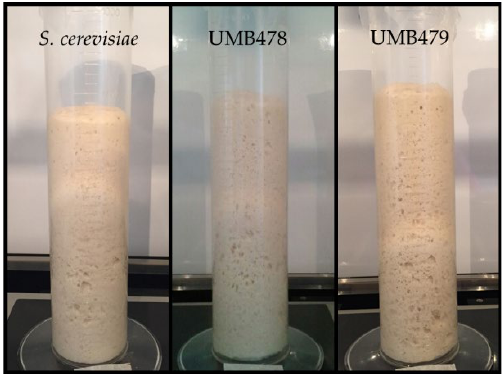
Figure 2. Doughs leavened (6 h) by S. cerevisiae , Z. mobilis UMB478 and UMB479. Z. mobilis UMB478 produced a maximum dough volume increase of 588 ± 18 mL in 6 h of leavening, doubling the initial volume in 3.5 h. The total CO 2 produced was only 34.6 ± 5.4 mL, and the dough pH decreased from 5.89 ± 0.00 to 5.27 ± 0.04. The data obtained by HPLC analysis confirmed the difficulty of this strain in leavening the dough (Figure 3, first row). As previously reported, this strain frequently produces cell aggregates, so far the viable count (UFC/g) was lower than the total count (cells/g): Z. mobilis UMB478 inoc- ulated at 5.66 ± 0.19 Log (CFU/g) highlighted a 1 Log increase during leavening. Z. mobilis UMB479 produced a high amount of CO 2 during the leavening trials (ap- proximately 101.0 ± 1.8 mL), doubling the initial dough volume in 2 h and reaching a final